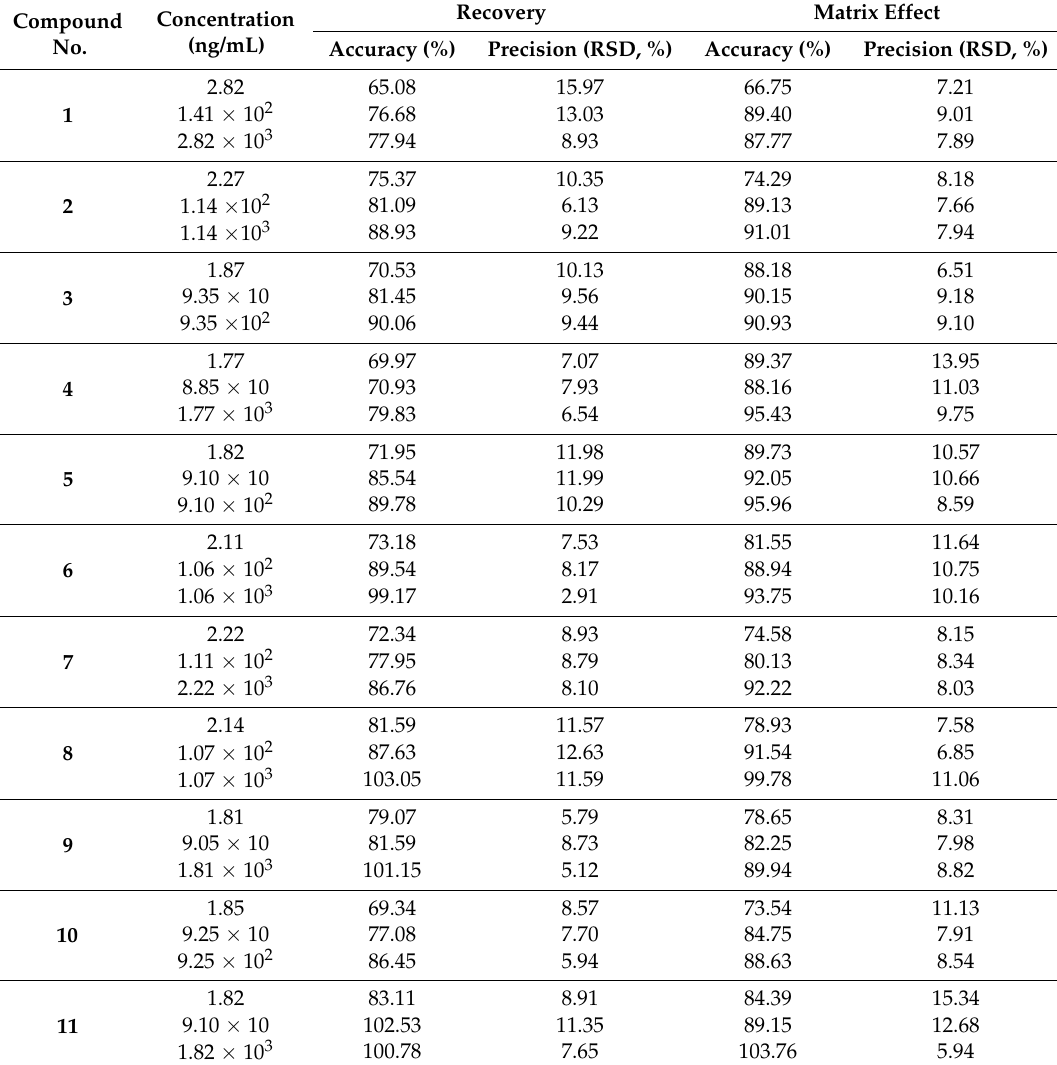
Table 4. Recoveries and matrix effects of the eleven compounds in rat plasma.